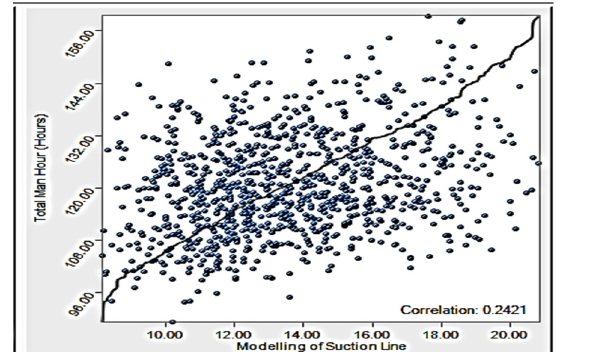
Fig. 4: Correlation between Modeling of Suction Line and Total Man Hours